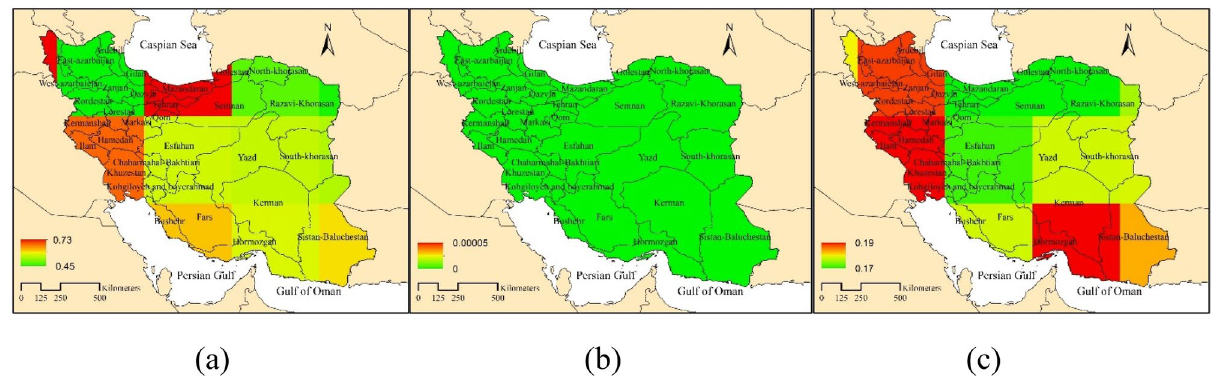
Figure 4. Time series trend analysis of carbon dioxide concentration using Mann–Kendall test ( a ), P value ( b ) and Theil-Sen slope ( c